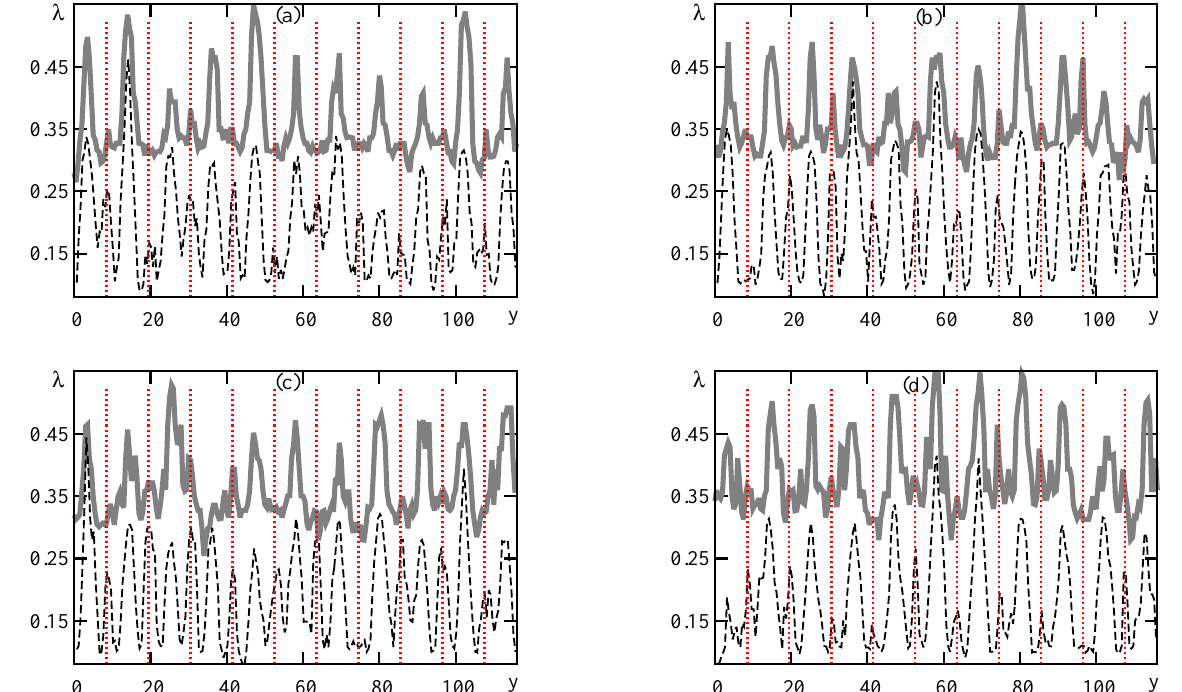
Figure 6. The irregularity index computed in 4-year sliding windows for synthetic data averaged over 162 (solid gray) and 648 (dashed black) days ( m =2). Model parameters: a =0.8, h =0.4, c =1.7, k =0.35, and intermediate period variation T 2 set at 450 (a) , 610 (b) , 700 (c) , 800 (d) days. Red dashed vertical lines at solar sunspot